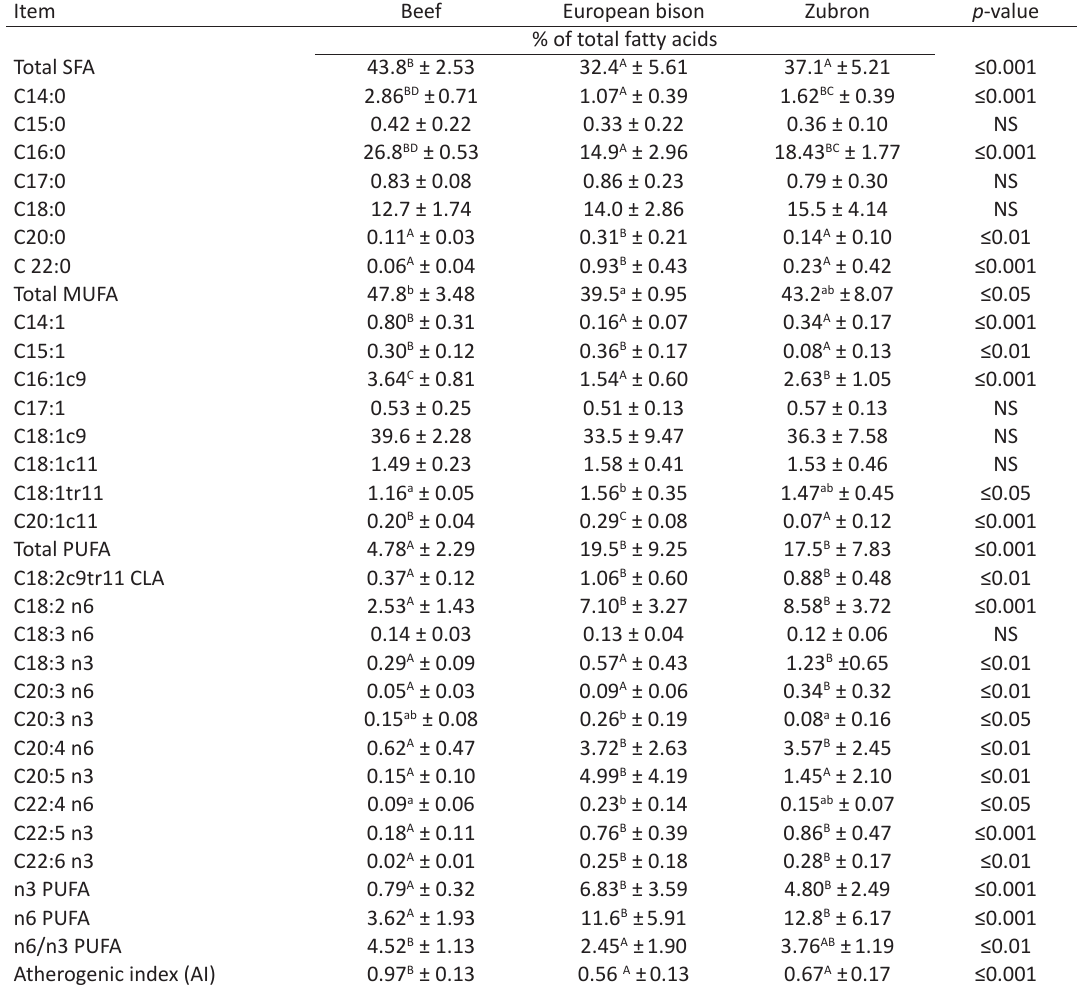
Table 3. Fatty acid profile and atherogenic index of raw musculus semitendinosus